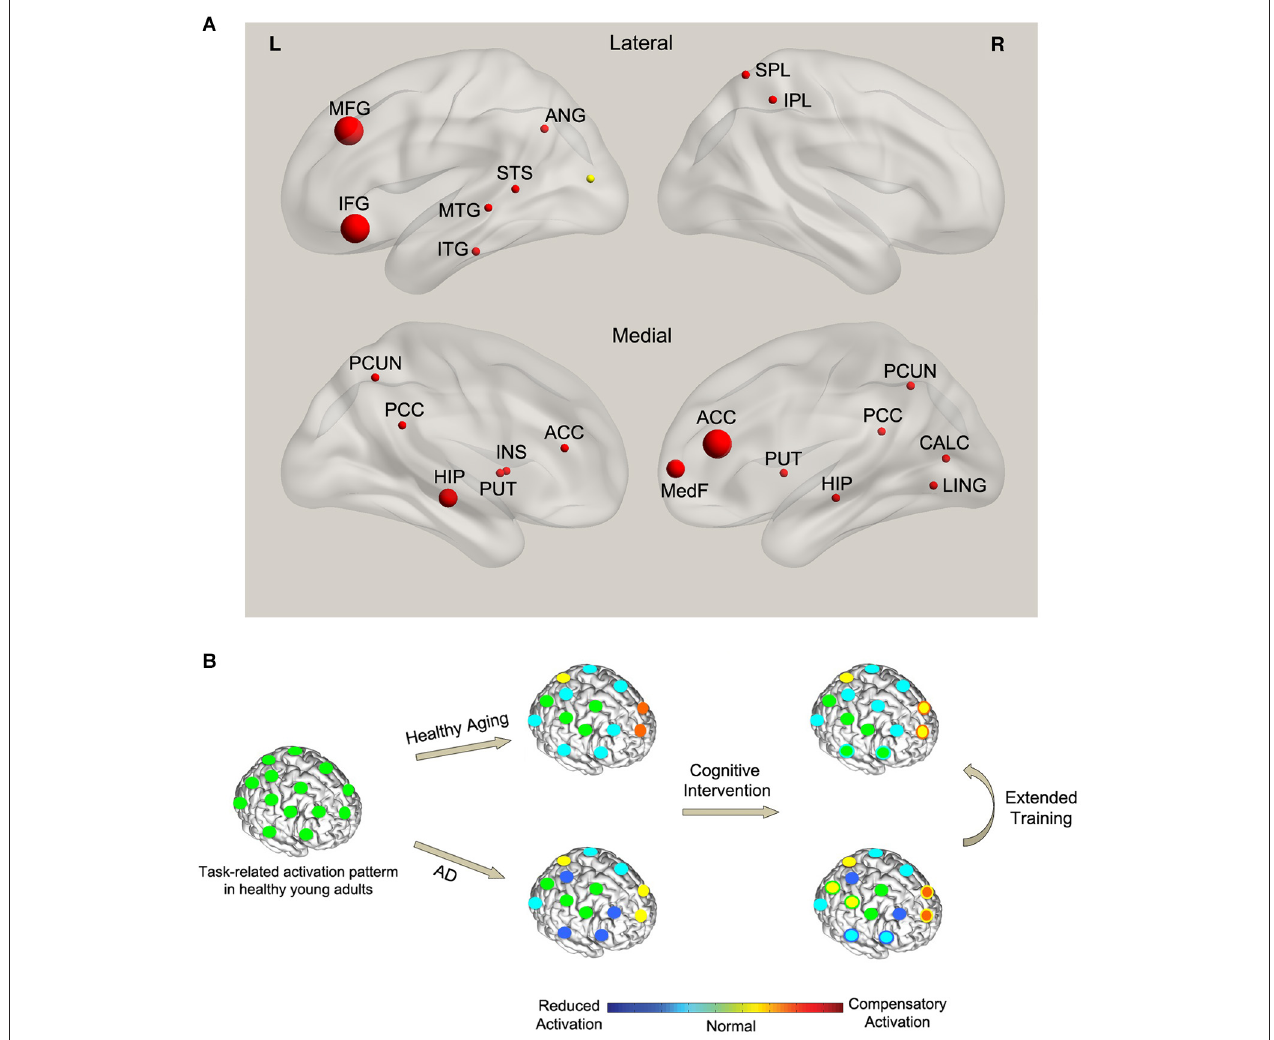
compensatory network (yellow circles). Right panel: cognitive training in healthy aging leads to normalization of brain activity in some of the task-specific regions (green circles with cyan boundary) as well as reduced compensatory activations (yellow circles with orange boundary). This pattern is consistent with the cognitive training literature showing a combination of training-related increase (normalization) and decrease (less compensation) in activity in healthy aging. On the other hand, training in AD leads to partly restoration of the activity in some of the task-specific regions (cyan circles with blue boundary) parallel with recovery of part of the compensatory network (orange circles with yellow boundary) and recruitment of new compensatory networks (yellow circles with green boundary). This pattern is consistent with the observed dominant increase in brain activity (combination of restoration and compensation) in AD after